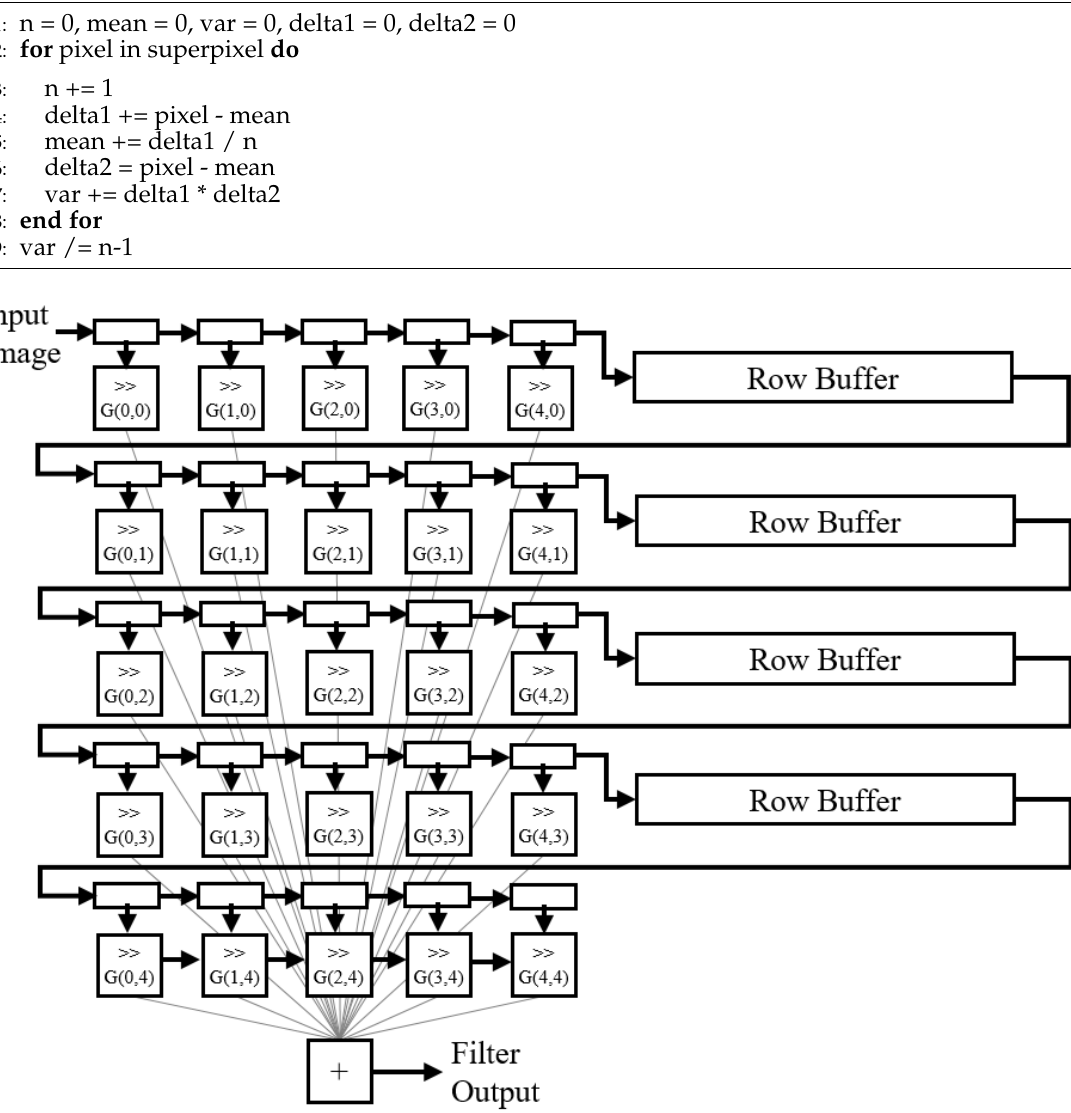
Algorithm 1 Modified Welford algorithm for calculating mean and variance in a single pass